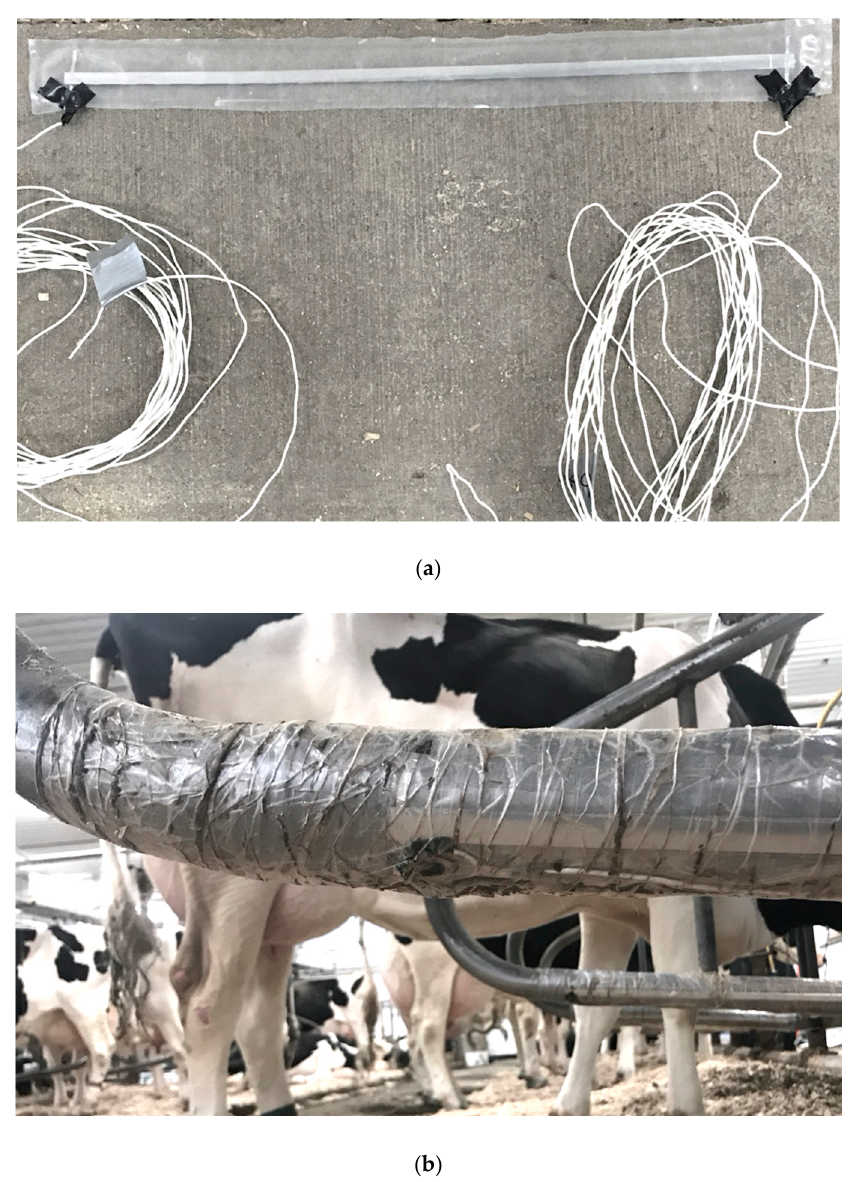
Figure 1. Photographs depicting ( a ) the full length of an individual contact mat (CM) within a water-resistant plastic coating, with the metal ends soldered to 1.5 m of 18 AWG wire and coated in electrical tape for insulation prior to stall attachment; and ( b ) a portion of an individual CM affixed to the left stall divider using duct tape (Canadian Technical Tape Ltd., Saint-Laurent, QC, Canada) at the end and clear packing tape along the length of the metal band. The CM shown has been positioned so that the pressure-sensing metal band is levelled at approximately a 45 ◦ angle to the ground. This photograph was captured at the end of the trial period to show the condition of the CM after an 8 week